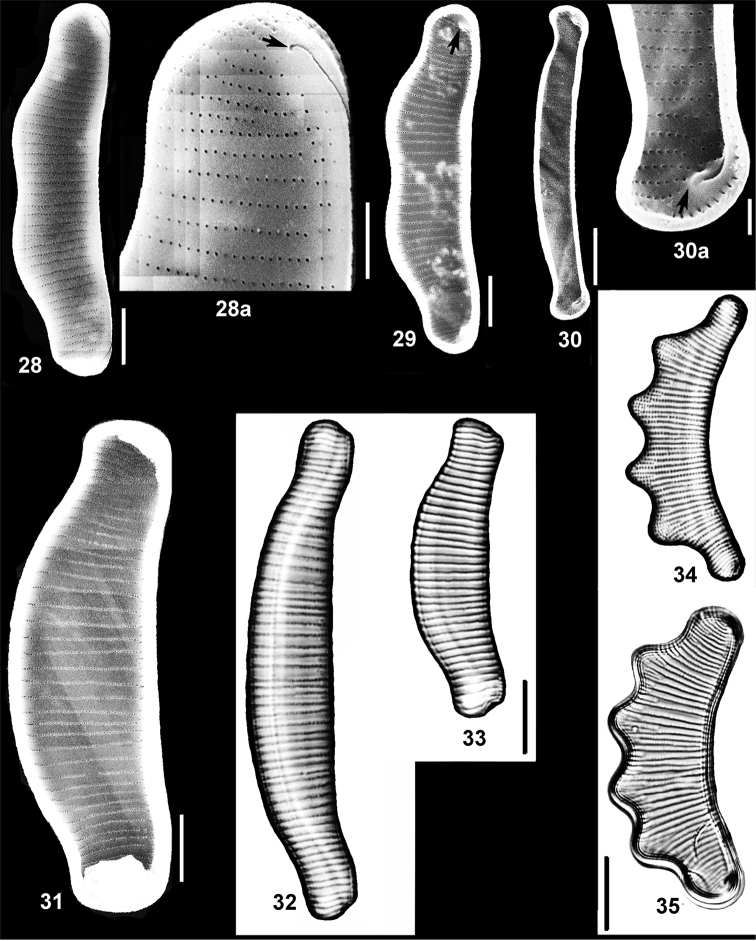
Species of Eunotia Ehrenb. from the Cheremsky Nature Reserve. 28, 28a, 29Eunotiadorofeyukiae Lange-Bert. & Kulikovskiy 28a arrow indicates pore outer on the raphe slit distal end 29 arrow indicates rimoportula at the venral corner of pole where raphe slit distal end finishes on the outer valve surface 30, 30aEunotianeocompacta S. Mayama 30a arrow indicates rimoportula at the venral corner of pole, absence of a hyaline field indicates absence of terminal fissure 31Eunotiapraerupta Ehrenb. 32Eunotia sp. 6. 33Eunotia sp. 7. 34, 35Eunotiatetraodon Ehrenb. Figs 28–31 SEM: 28, 28a outside valve surface; 29–31 inside valve surface; 32–35 LM. Scale bars: 5 µm (28, 29, 30); 2 µm (28a); 1 µm (30a); 10 µm (31–34).